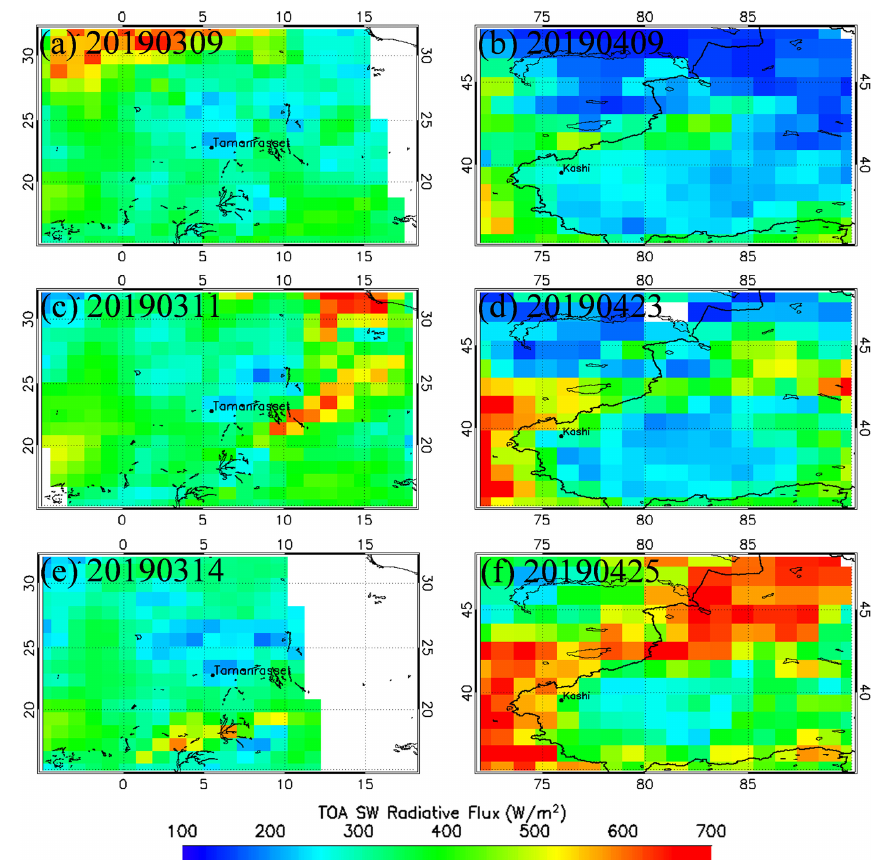
Figure 5. TOA SW radiative flux derived from AQUA/CERES over the Sahara in March 2019 and over the Taklimakan Desert in April 2019.